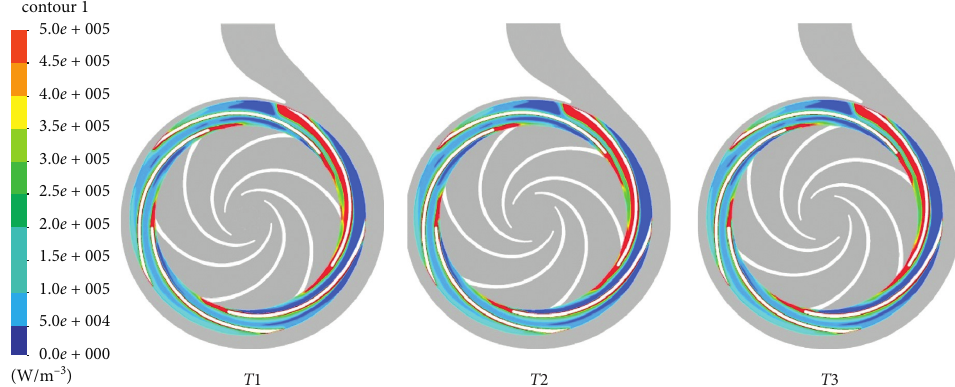
Figure 11: Entropy production rate in different moments at ( Q ) � 48m 3 /h in guide vane.